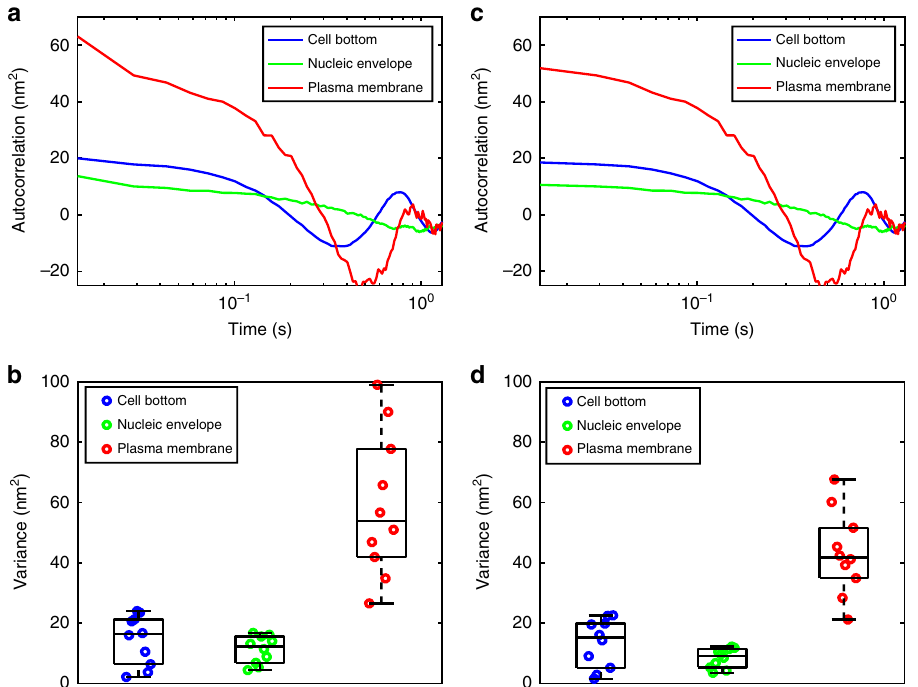
Fig. 3 Temporal autocorrelation and variance analysis of nucleic envelope and plasma membrane fl uctuations. a Original autocorrelation plot for cell bottom, nucleic envelope, and plasma membrane at a single spatial position of the corresponding interface. b Dot plot of variance of membrane fl uctuations measured at multiple spatial locations based on the autocorrelation plot shown in a , which is the correlation value obtained at the 0-time point. The line within each box represents the median, and the lower and upper boundaries of the box indicate the fi rst and third quartiles, respectively. Error bars (whiskers) represent the interquartile range ( n = 10). c Extrapolated autocorrelation plots, where white noise at the zero-time point has been corrected. d Variance of membrane fl uctuations measured at multiple spatial locations based on the extrapolated autocorrelation plots c . The line within each box represents the median, and the lower and upper boundaries of the box indicate the fi rst and third quartiles, respectively. Error bars (whiskers) represent the interquartile range ( n =